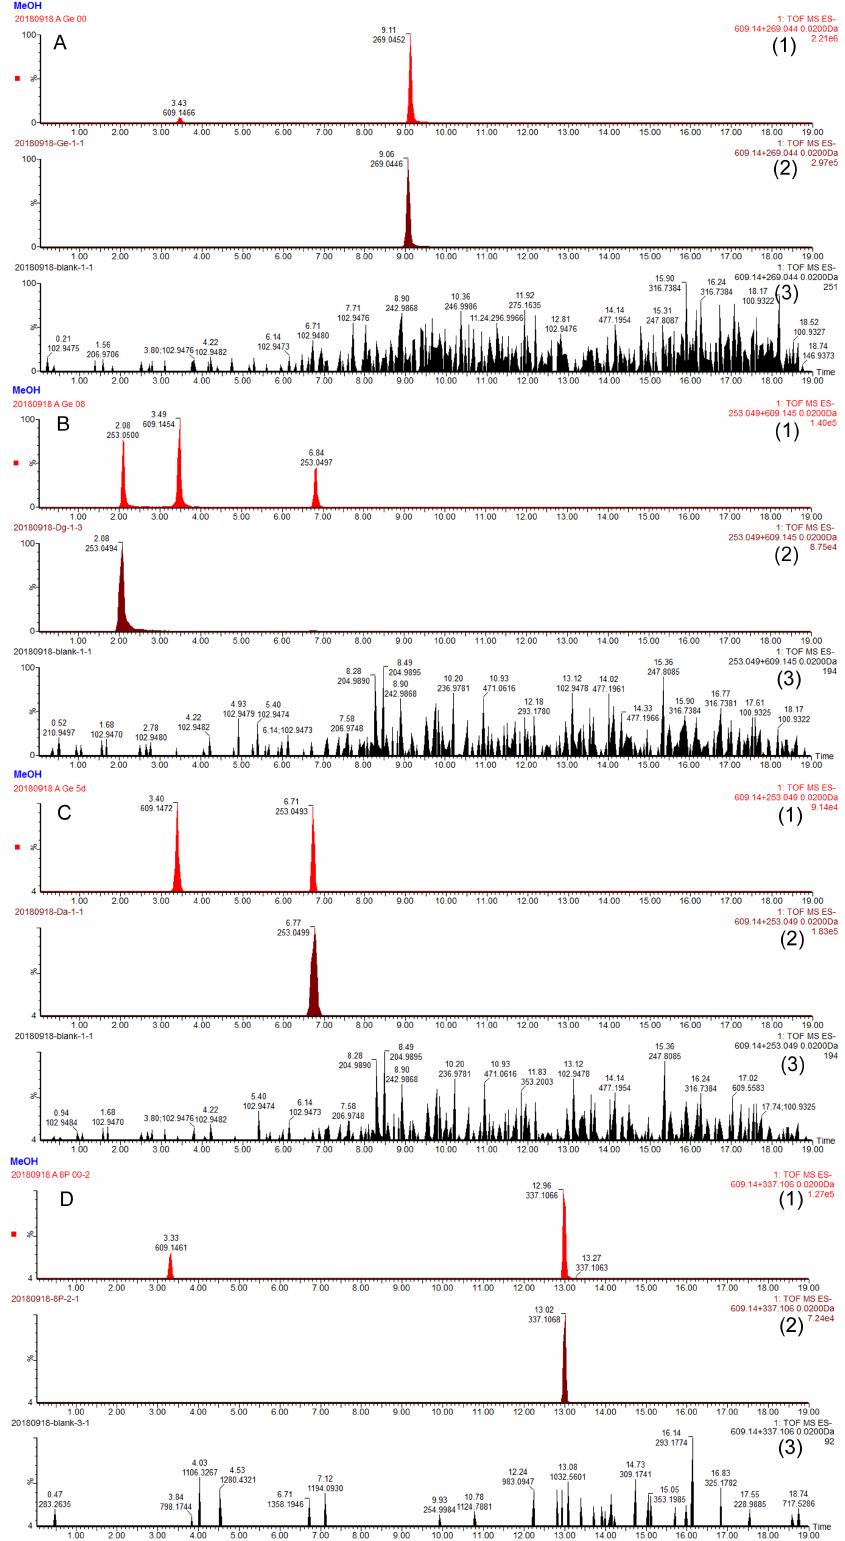
Figure 2. The typical chromatograms of ( A ) genistein, ( B ) dihydrogenistein and 5-hydroxy equol at 8 h, ( C ) 5-hydroxy equol on the fifth day, ( D ) 8-prenyl genistein and rutin (internal standard, IS) in anaerobic incubation of rat-gut microflora. ( 1 ) Genistein and 8-prenyl genistein incubated in gut microflora and spiked with IS; ( 2 ) blank microflora spiked with four flavonoids; ( 3 ) blank